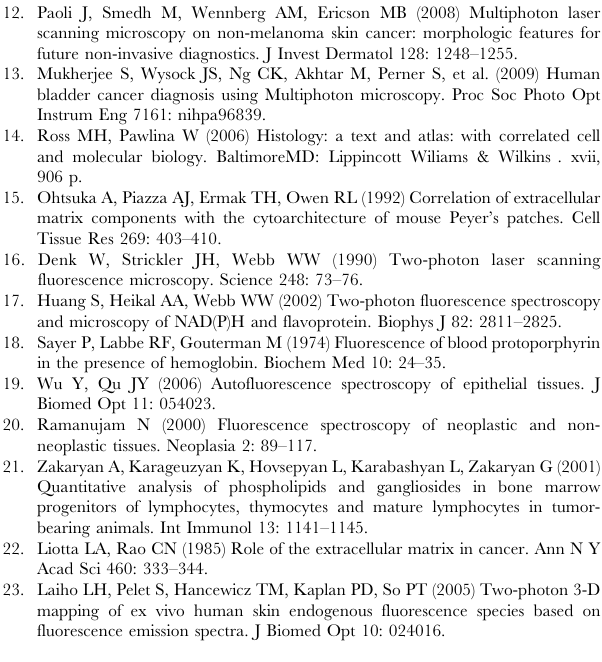
Figure S3 False color merges of component images. In (A), component images are shown with false color with the merge at right. The color scheme used is consistent for all the unmixed images in B–F, with yellow corresponding to epithelium, white to lamina propria, blue to collagen, and green to lymphocytes. Scale bars for all images are 50 m m. (B) At the crypt level of colon, the epithelial tissue is surrounded by a mixture of the three other components: lamina propria, collagen, and lymphatic tissue. Corresponding histology (G) shows connective tissue around the crypts (black arrow) as well as a few dark staining lymphatic cells (red arrow). (C) In the small intestine, the main components of the cores of the villi are lymphatic tissue and lamina propria. Histology (H) shows epithelium surrounding each villus and loose connective tissue forming the core of the villi. (D) At the boundary of a Peyer’s patch and the crypt level of small intestine, all four components are visible. Lamina propria signal is particularly strong along the blood vessel at the boundary (arrow) (I) Histology of the Peyer’s patch boundary. (E) Close up of the lymphatic cells that comprise a Peyer’s patch. The strong signal from lymphatic tissue and collagen ‘co-stain’ this false color merge. Peyer’s patch histology (J) shows the darkly staining nuclei of lymphatic cells, but without special staining cannot identify the connective tissue. (F) Merge shows the spatial registration of the four components in a neoplastic region of an APC min / + mouse. Histology of a lesion (K) shows a thickened and irregular epithelium which is characteristic of neoplasia. Figure S4 Intrinsic contrast two-photon microscopy image of an unstained, fixed, paraffin embedded colon tissue sample. Images were acquired at an excitation wavelength of 850 nm, at various depths within the paraffin block as indicated by the z value in the upper right corner of each